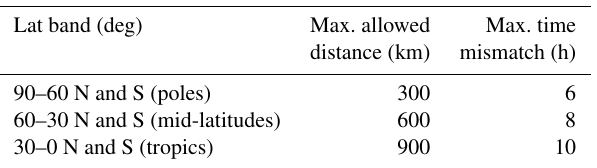
Table 2. Latitude-dependent matching criteria used for the inter- comparisons with ACE-FTS measurements.